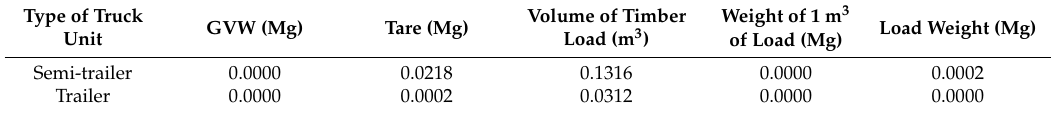
Table 3. Results of the analysis of significant differences between selected measures by type of truck unit.